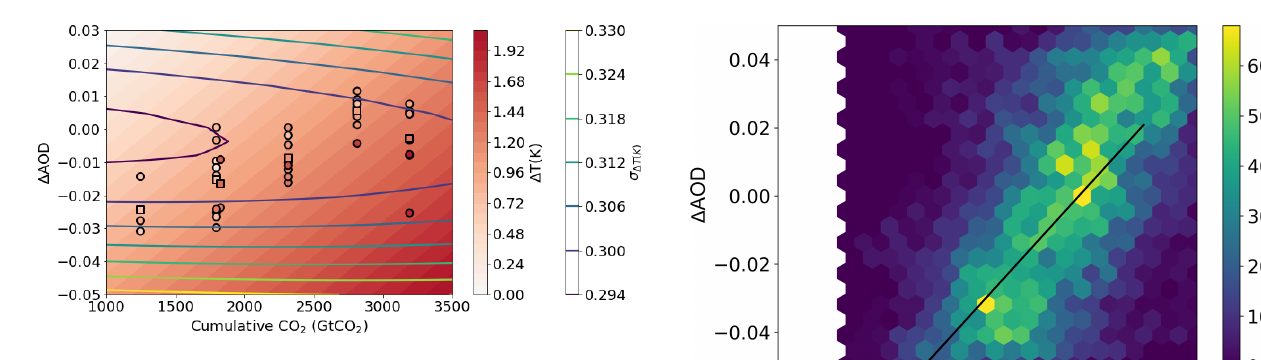
Figure 5. Global mean surface temperature response to a change in aerosol optical depth (AOD) or cumulative atmospheric CO 2 con- centration relative to the 2015–2020 average as emulated by ESEm using Gaussian process regression trained on CMIP6 ScenarioMIP outputs (shown as circles, the multi-model mean for each scenario is shown as a square point). The contour lines represent the 1 σ un- certainty in the emulator values (in Kelvin).